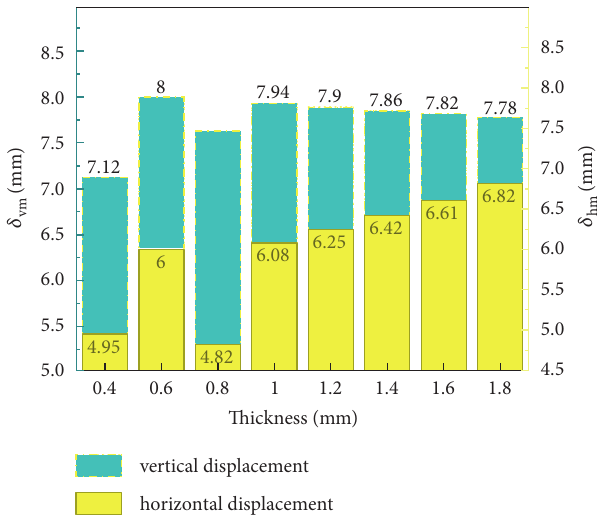
Figure 14: Horizontal and vertical displacements of the station floor near the foundation